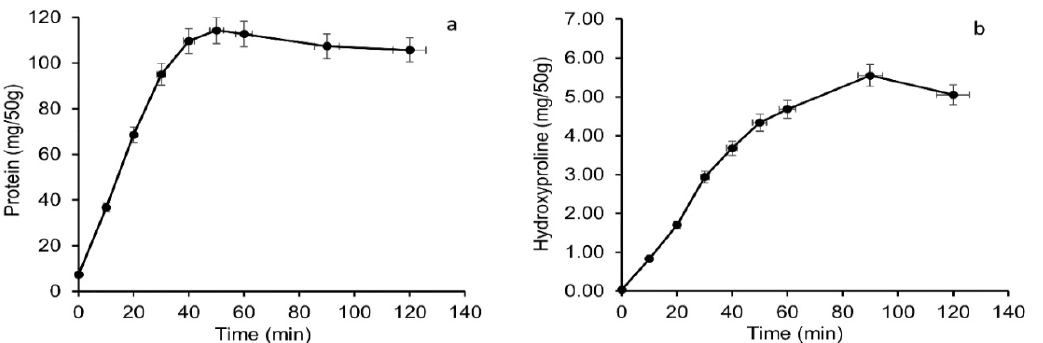
Figure 1. Total soluble protein ( a ) and hydroxyproline ( b ) contents as a function of time during the alkaline treatment of salmon bones. Bars represent the standard deviation (n = 3).